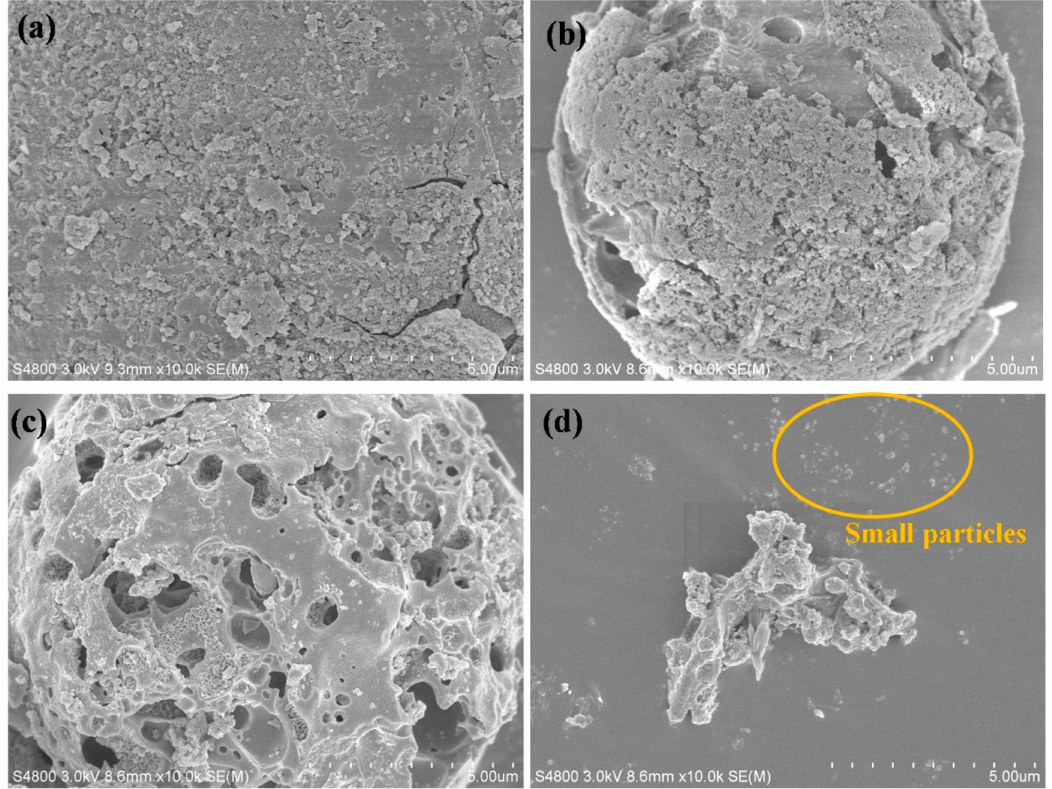
Figure 5. FE-SEM images of OPA particles at different concentrations of NaOH treatment after 30 min ultrasonication: ( a ) untreated OPA, ( b ) 1M NaOH treated OPA, ( c ) 2M NaOH treated OPA and ( d ) 3M NaOH treated